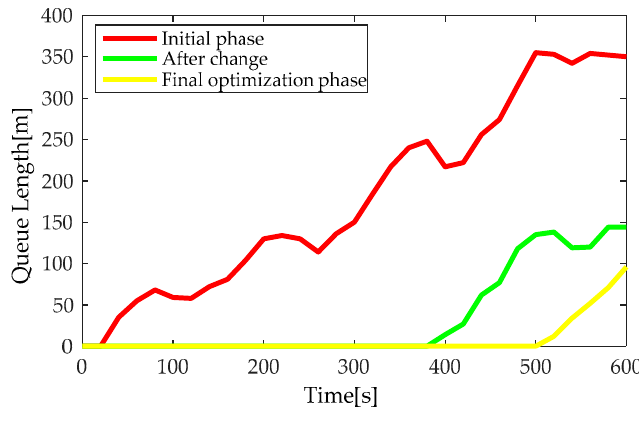
Figure 11. Simulation results.